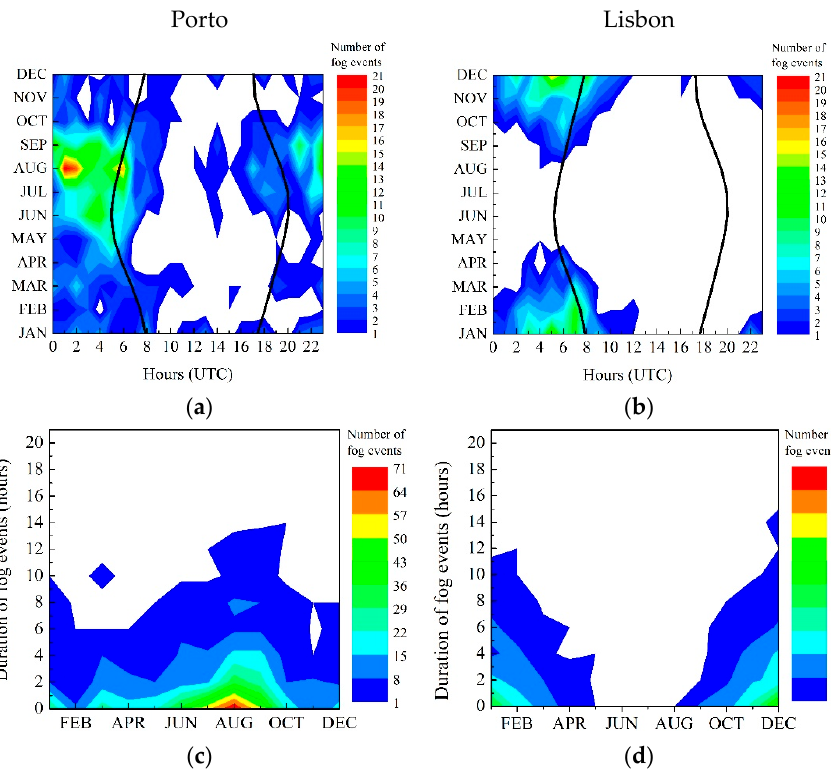
Figure 5. Distribution of the fog onset in the diurnal cycle where the time of the sunrise and the sunset are represented by solid lines represented by the panels ( a ) and ( b ). The panels ( c ) and ( d ) show the duration of the fog events for each month, scaled by the number of occurrences. Atmosphere 2020 , 11 , x FOR PEER REVIEW